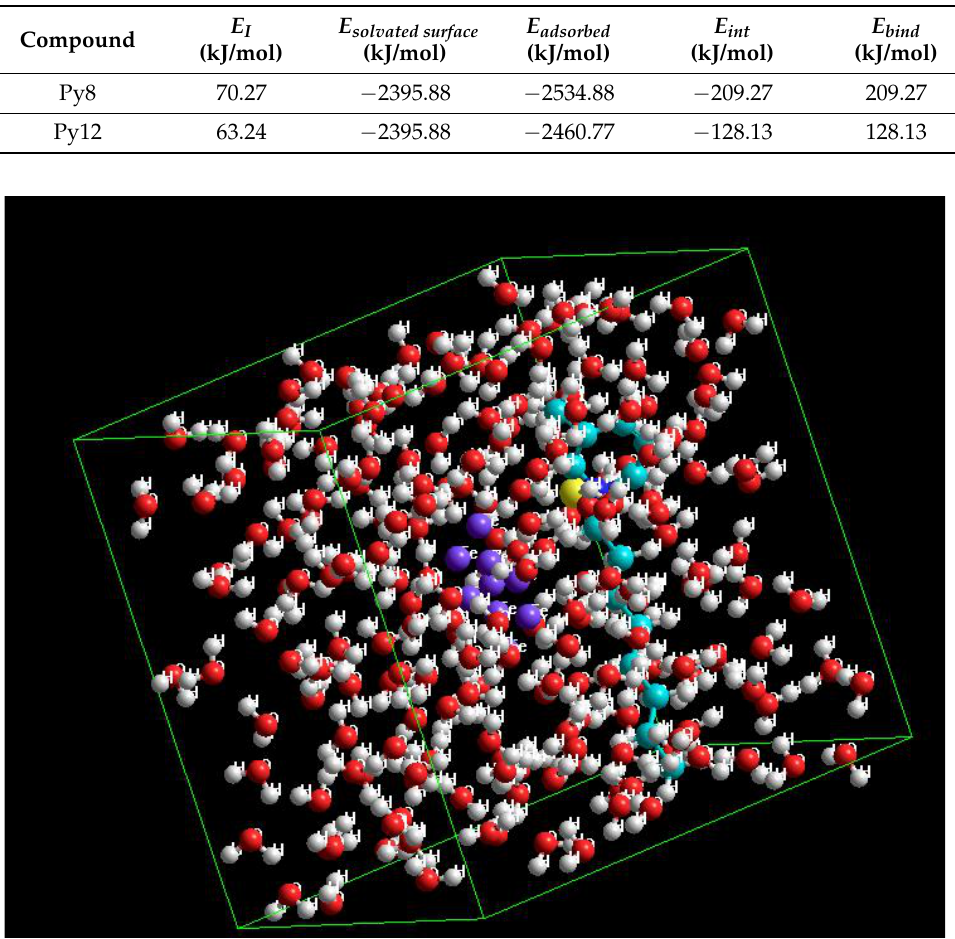
Figure 13. Schematic of iron atoms in the aqueous medium with parallel adsorption of Py8 evaluated using molecular mechanics (MM+). The atoms are color coded (Purple = Fe, Cyan = C, Red = O, White = H, Yellow = Br).